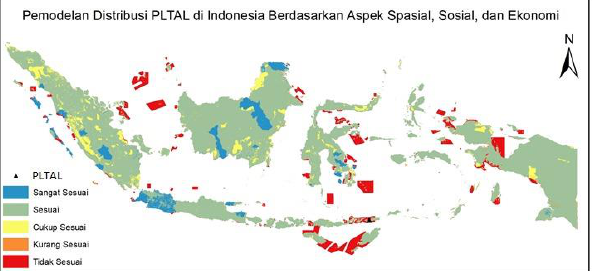
Figure 8 Pltal validation in Indonesia based on current data